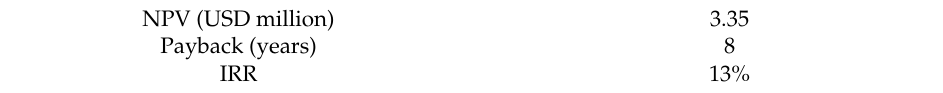
Table 9. Bioethanol project